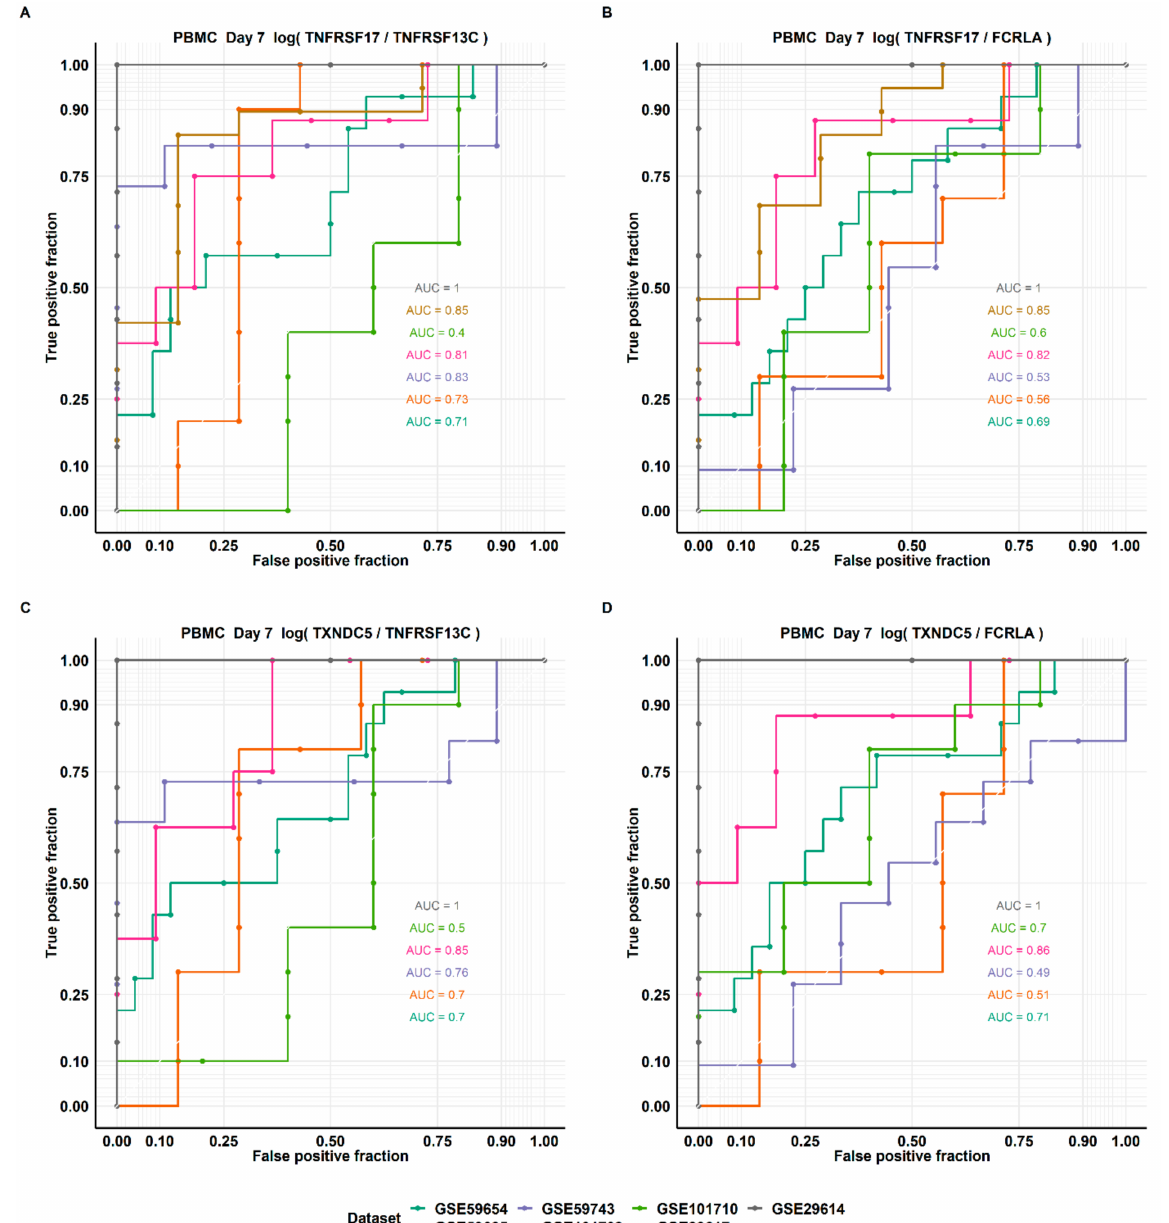
Figure 8. ROC curves of Day 7 Direct B lymphocyte LS-TA of TNFRSF17 ( A , B ) and TXNDC5 ( C , D ) using two different B lymphocyte informative reference genes (TNFRSF13C and FCRLA). The performance of the single cell-type biomarker parameters was analyzed by ROC with responder as a positive